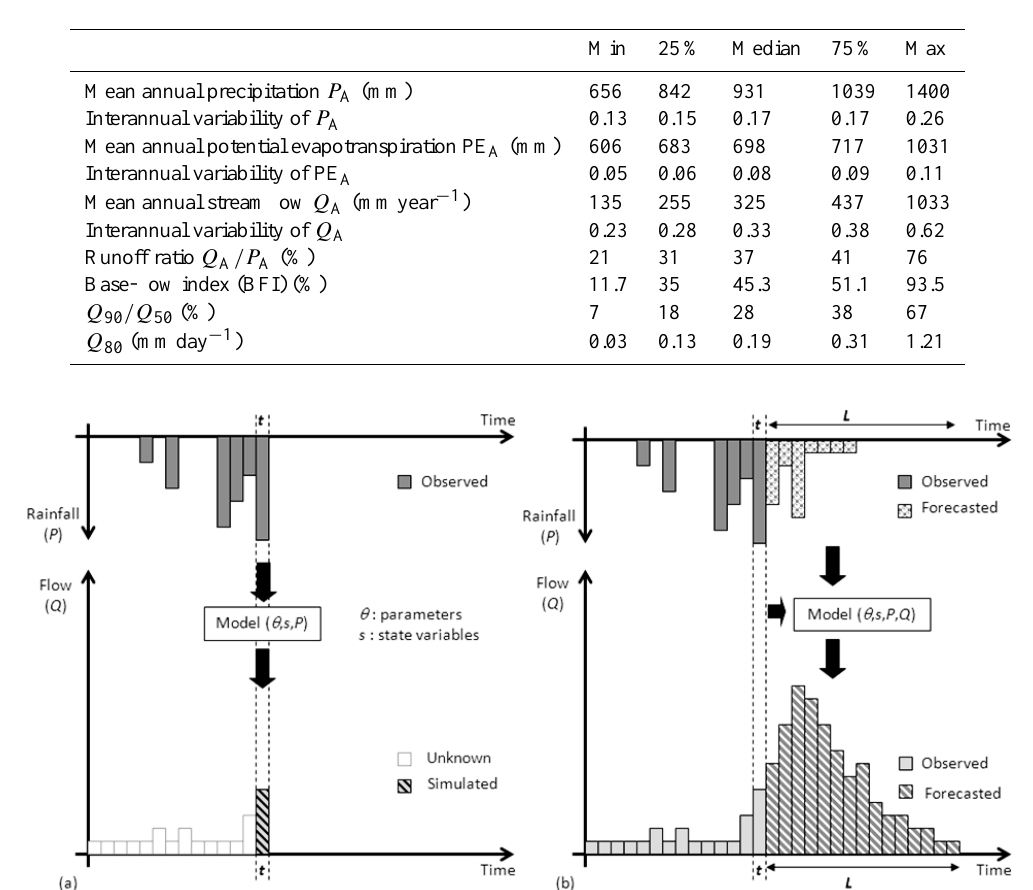
Figure 2. Schematic representation of the difference between (a) simulation and (b) forecasting modes ( L : lead time).